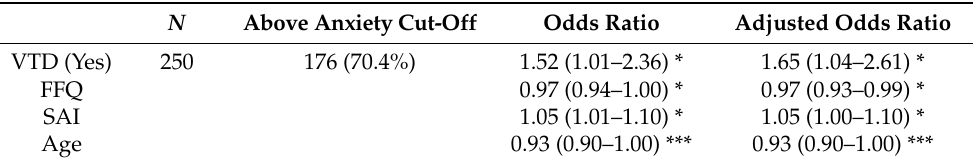
Table 4. Bivariate (OR) and multivariate (AOR) logistic regression predicting clinically significant generalized anxiety symptom scores.